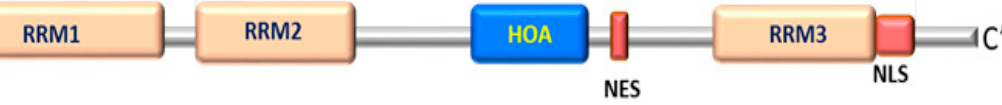
Figure 2. Structure of the RBM45 gene.